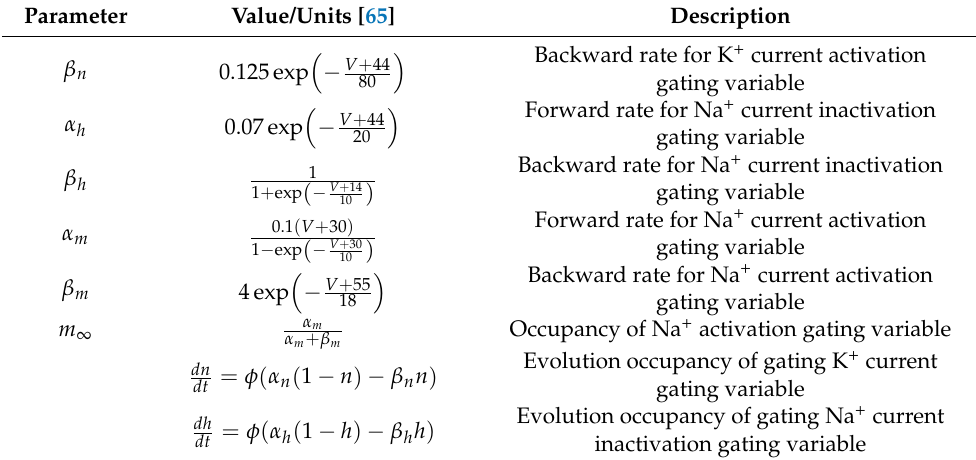
Table 8. Parameter values for membrane potential equations.